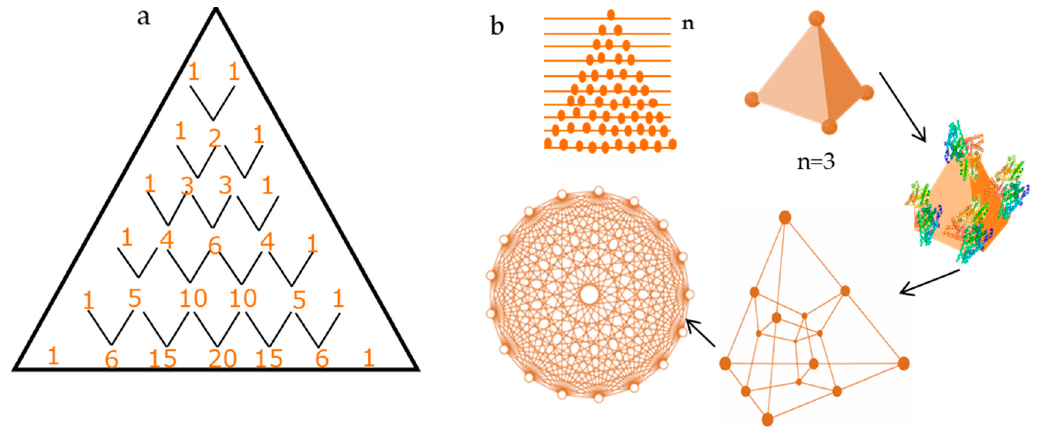
Figure 3. Comparison of the ring pattern to geometric design: ( a ) AFM image of a single protein ring pattern and ( b ) geometric n -simplex.